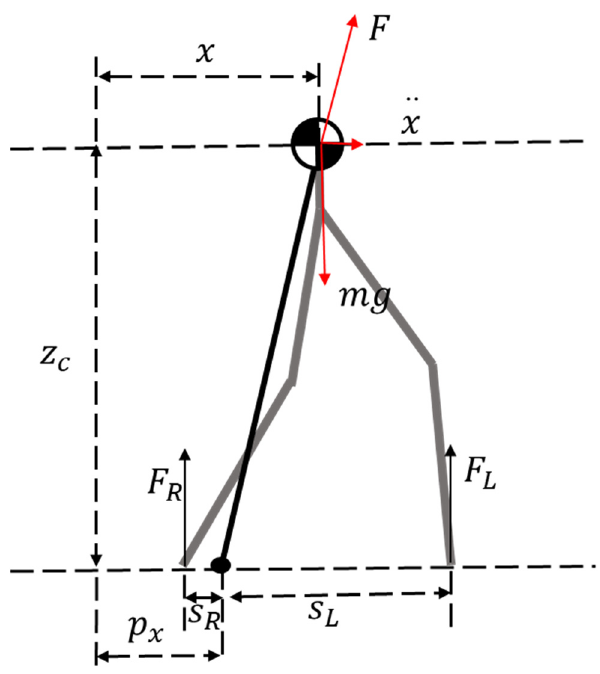
Figure 2. The linear inverted pendulum model of the humanoid robot.